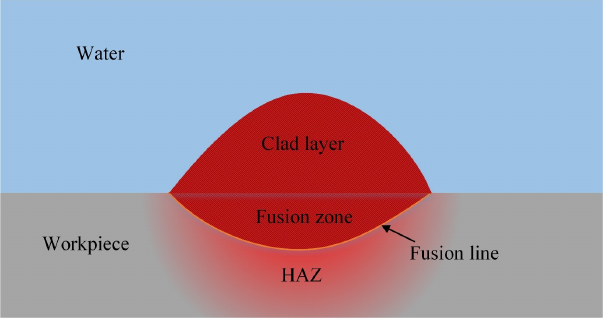
Figure 3. The schematic view of the welded bead geometry characteristic.